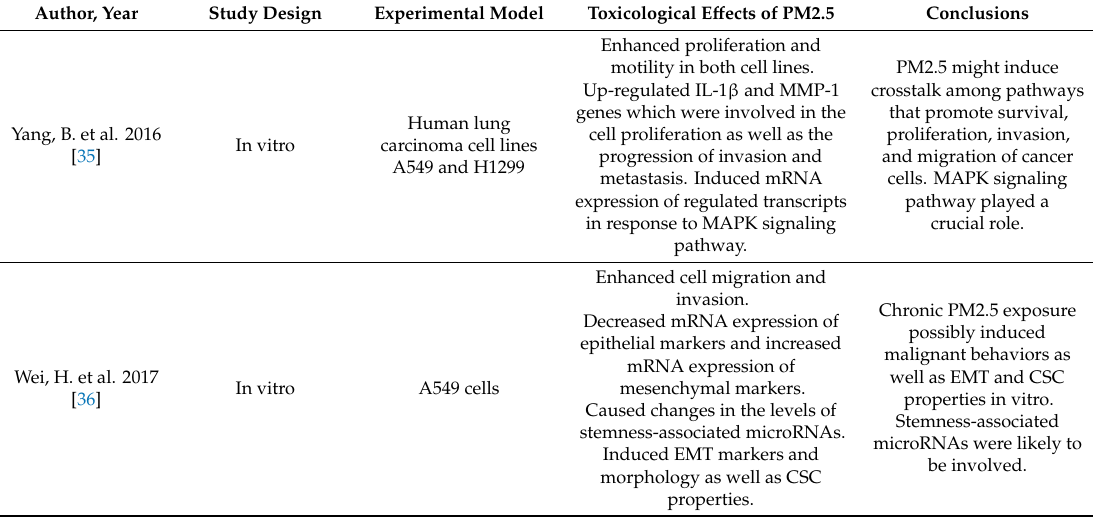
Figure 3. Schematic representation of the cellular pathways of carcinogenic effects induced by oxidative stress through PM2.5-mediated ROS production. Upon chronic exposure to PM2.5, oxidative stress derived from increased ROS production might lead to the activation of signaling pathways, the modulation of transcription factors, and the impairment of DNA, which might together induce tumor initiation and progression. This suggests the potentials of antioxidant therapies as promising strategies in the reduction of cancer diseases caused by redox homeostasis imbalance. Table 1. A summary of experimental studies on the toxicological effects of PM2.5 involved in lung carcinogenesis.